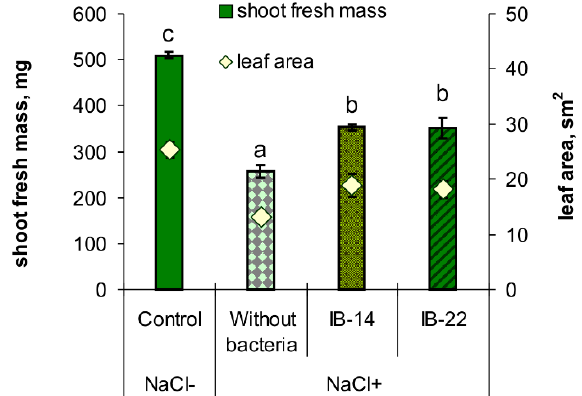
Figure 1. Effect of salt-stress and seed bacterial inoculation on leaf area and fresh shoot weigh of wheat plants at the stage of tillering in the field experiments: IB-14 —Pseudomonas mandelii IB–Ki14; IB-22— Bacillus subtilis IB–22; control—option without bacterization and salinity. Significantly different means ( n = 10) for each variable are labeled with different letters ( p ≤ 0.05; LSD test).